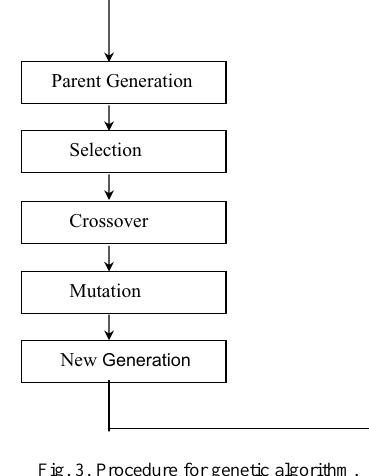
Fig. 3. Procedure for genetic algorithm.